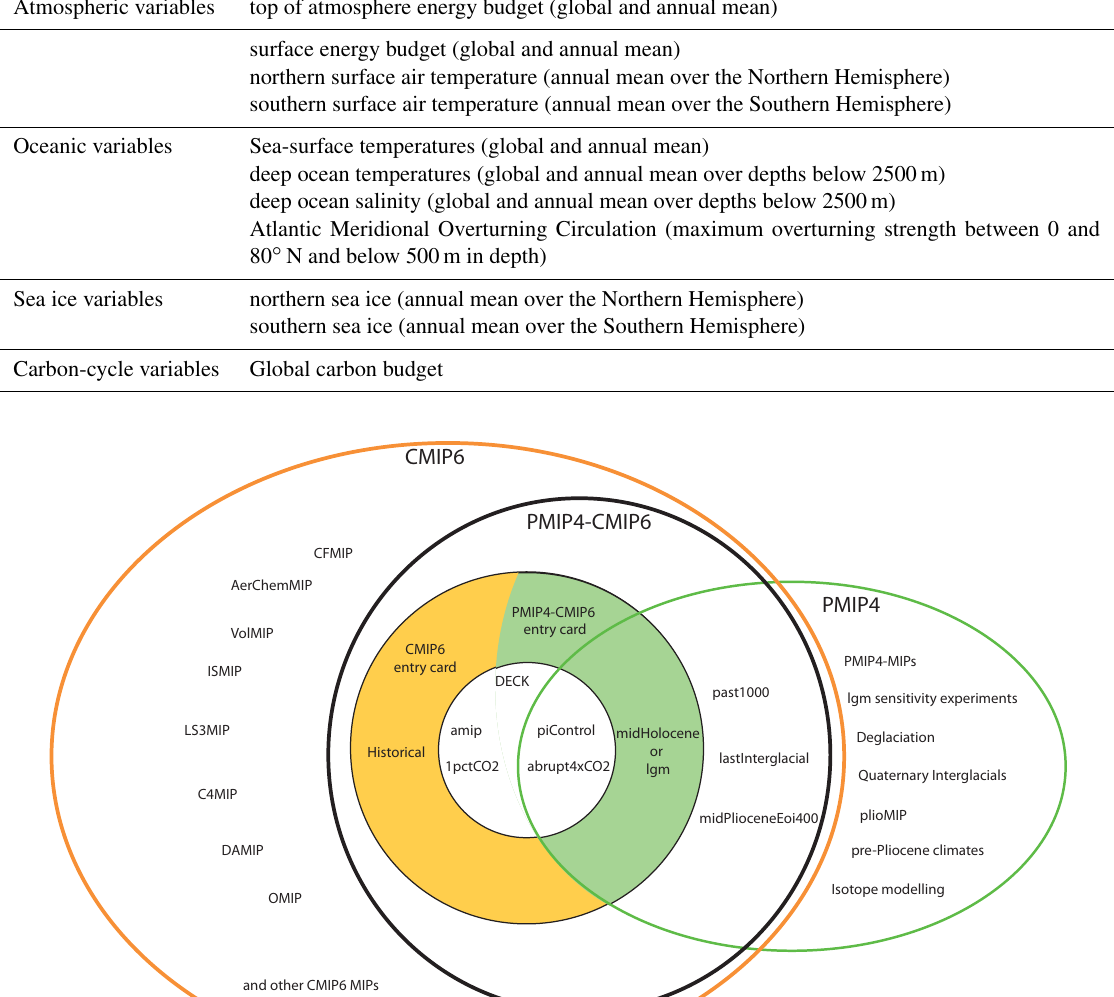
Table 5. Variables to be saved for the documentation of the spin-up phase of the models. Atmospheric variables